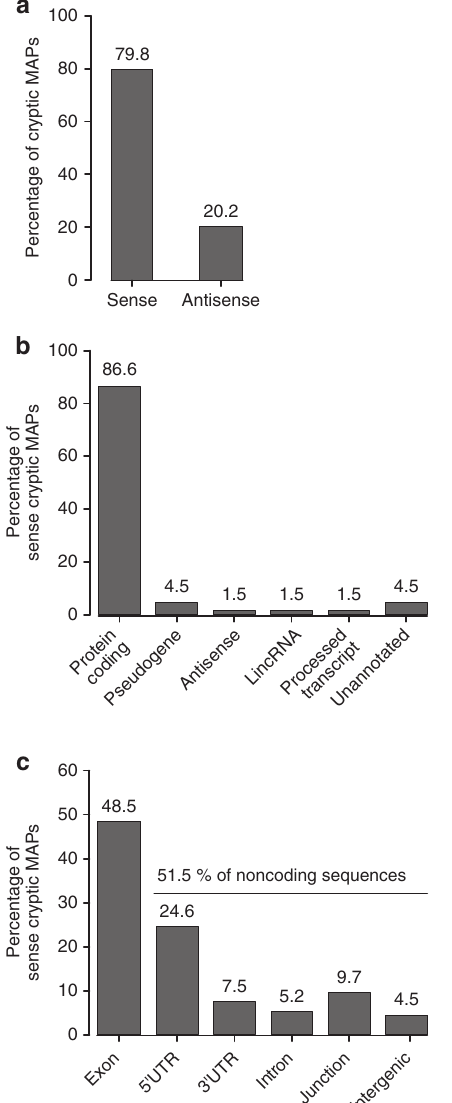
Figure 3 | Crypt. MAPs derive from both coding and noncoding transcripts. ( a ) Some Crypt. MAPs derive from novel antisense transcripts. Bar plot showing the percentages of Crypt. MAPs derived from sense and antisense transcriptions. ( b , c ) For Crypt. MAPs derived from sense transcription, we determined the percentage of each gene biotype in MAP source genes ( b ) and the proportion of Crypt. MAPs generated by six types of genomic regions ( c ). The ‘exon’ class refers to out-of-frame Crypt. MAPs, while the ‘junction’ category corresponds to peptides encoded by intron–exon or UTR–exon junction. LincRNA, long intergenic noncoding decreases along the transcript 28 . A small proportion of peptides (5.2%) derived from intronic sequences, a finding consistent with a report showing that a construct coding for the model SIINFEKL peptide, could generate MAPs after insertion into an intronic